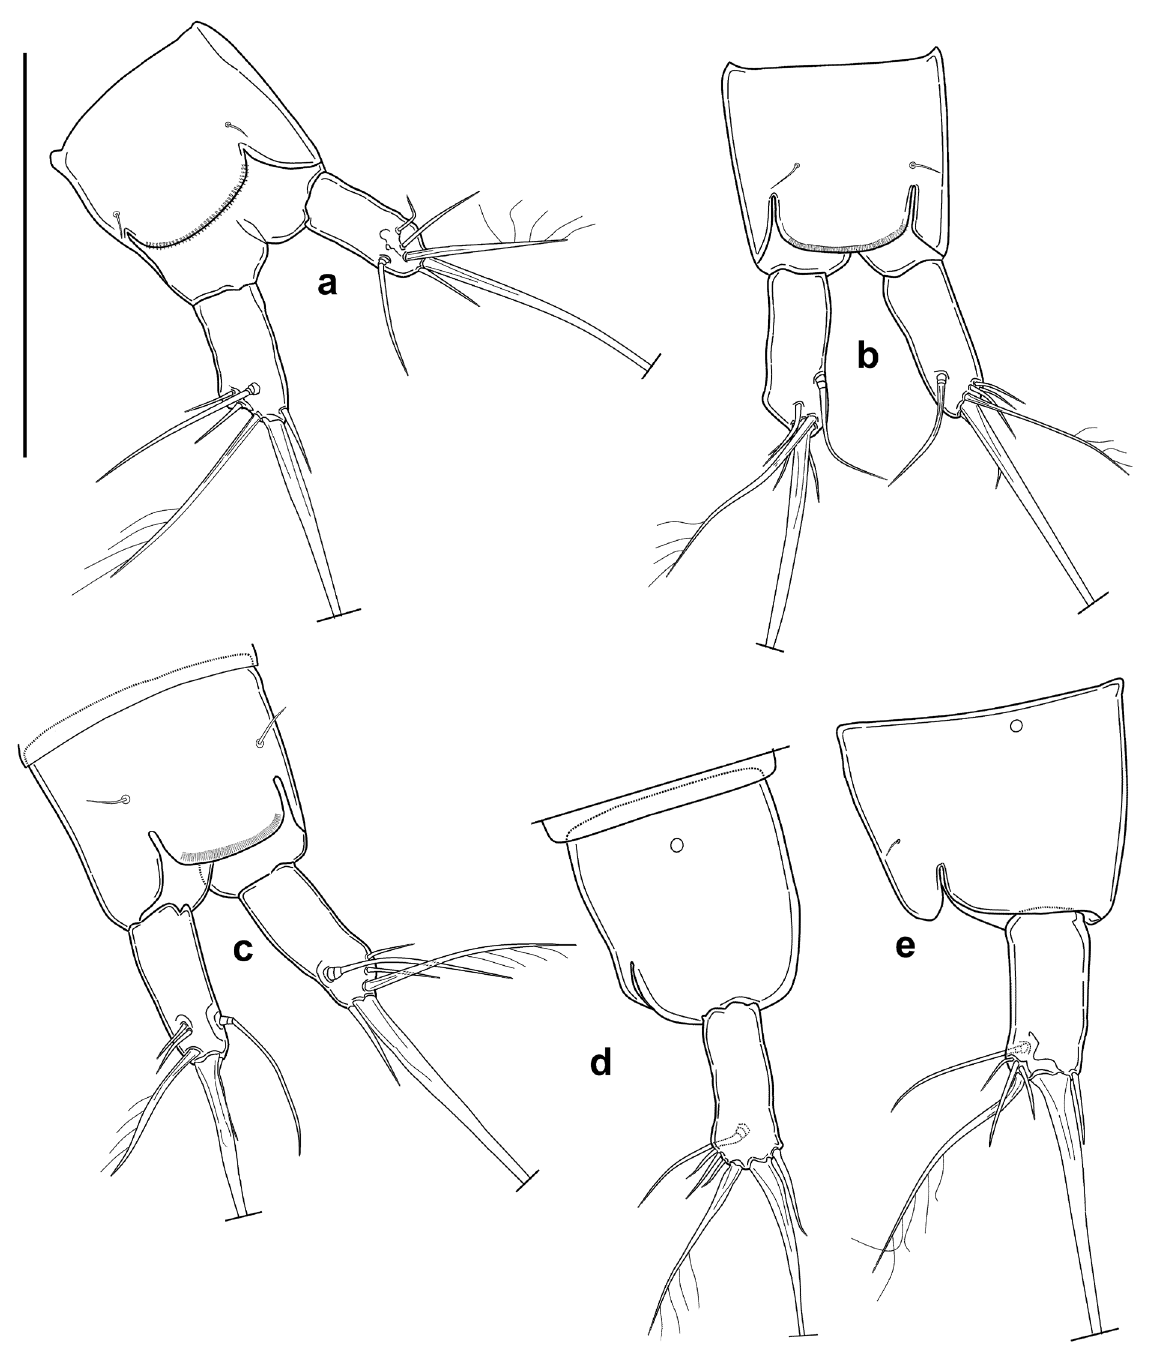
Fig. 3. Cottarellicaris sanctiangeli Bruno & Cottarelli sp. nov., ♂ (NHMUK). a . Anal somite, anal operculum and caudal rami, dorsal view. b . Anal somite, anal operculum and caudal rami, dorsal view (variability). c . Anal somite, anal operculum and caudal rami, dorsal view. d . Anal somite, anal operculum and caudal rami, lateral view (variability). e . Anal somite, anal operculum and caudal rami, lateral view (variability). a: Grotta superiore di Sant’Angelo; b, d: Grotta del Banco di ferro; c, e: Grotta Vucco Ucciardo. Scale bar: 50